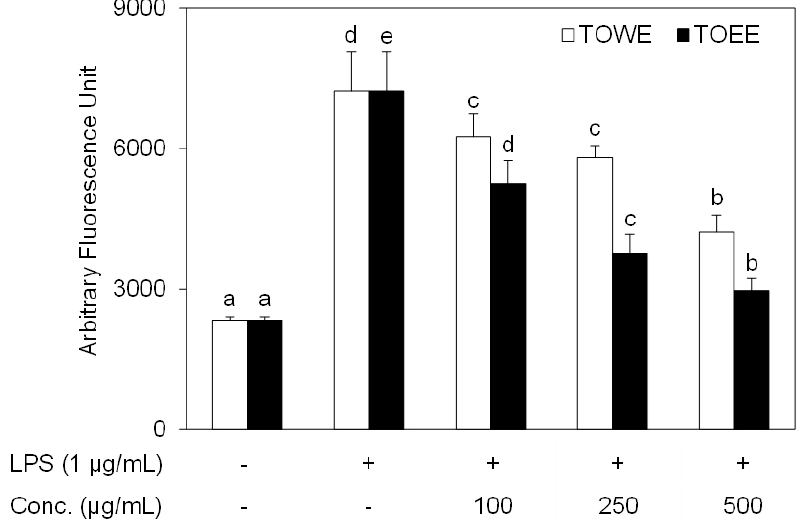
Figure 1. TOWE and TOEE scavenged LPS-induced ROS formation in RAW 264.7 cells. The cells were incubated with 50 μ M of DCFH-DA for 2 h. Then, either TOWE or TOEE was treated for 2 h and LPS was served (1 μ g/mL) for 30 min to generate ROS. The data represent the mean ± SD of triplicate experiments. The values sharing the same superscript are not significantly different at p < 0.05 by Duncan’s multiple range test. TOWE, T. officinale water extract; TOEE, T. officinale ethanol extract; LPS, lipopolysaccharide; conc, concentration.